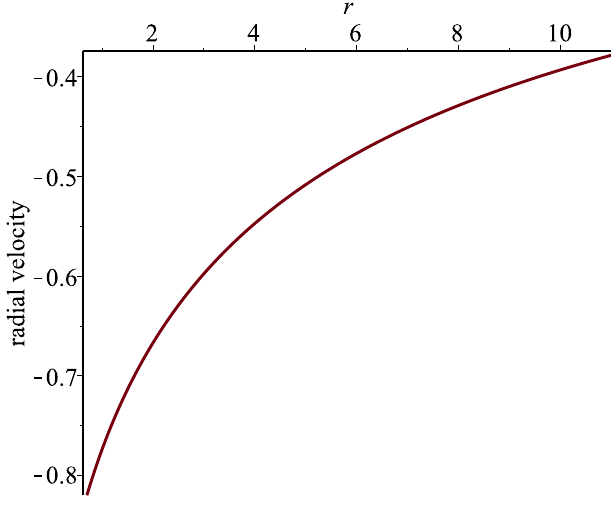
Figure 9. Behaviour of ˙ r for the Schwarzschild geometry in Kerr–Schild coordinates for m = 1 and (cid:101) = 1. Note that the coordinate velocity at the horizon is − 2/3 and that the coordinate velocity remains negative between the horizon and spatial